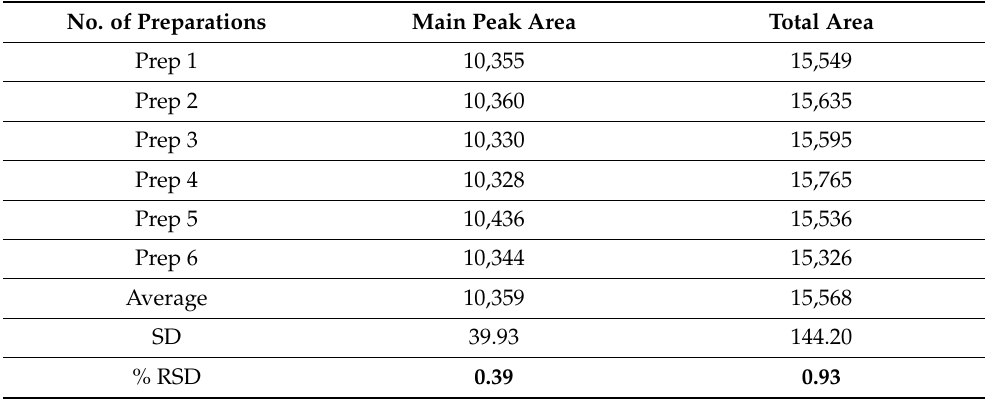
Table 5 . Qualification data set for repeatability set 2 experiment using 6 different samples of 3.0 mg/mL concentration.